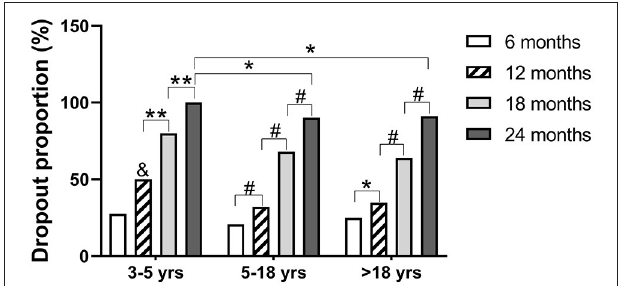
FIGURE 1 | Dropout rates at different duration of SLIT. Patients were divided into three groups according to age when SLIT was initiated. The patients who transferred from SLIT to SCIT were also included in dropout cases. * P < 0.05; ** P < 0.01; # P < 0.001; & P < 0.05 compared with the dropout rate at 12 months of the 5–18 years age group. SCIT, subcutaneous immunotherapy; SCIT, sublingual immunotherapy.